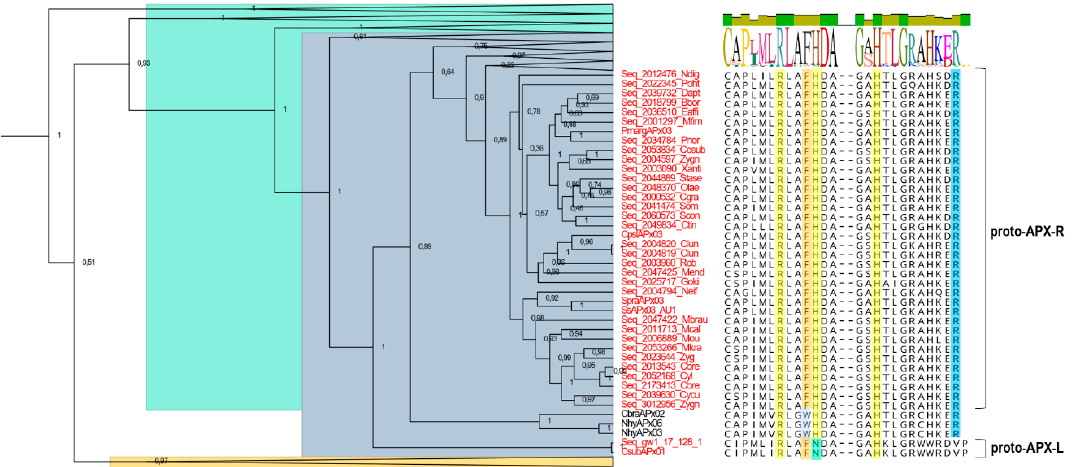
Figure 5. Detailed analysis of a clade from the APX cluster. Hybrid sequences derived from Charophytes that exhibit a single mutation from tryptophan to phenylalanine at position 41 are addressed as proto-APX-R. The loss of arginine at position 172 and the replacement of the distal histidine by an asparagine illustrate the diversification pathway towards APX-L establishment, for which reason these sequences are referred to as proto-APX-L. APX group is shown in blue; APX-R, in orange; and APX-L, in green. All other clades showed in Figure 1 were collapsed for better visualization. Sequence logo presented above the alignment shows a consensus sequence of all listed species.